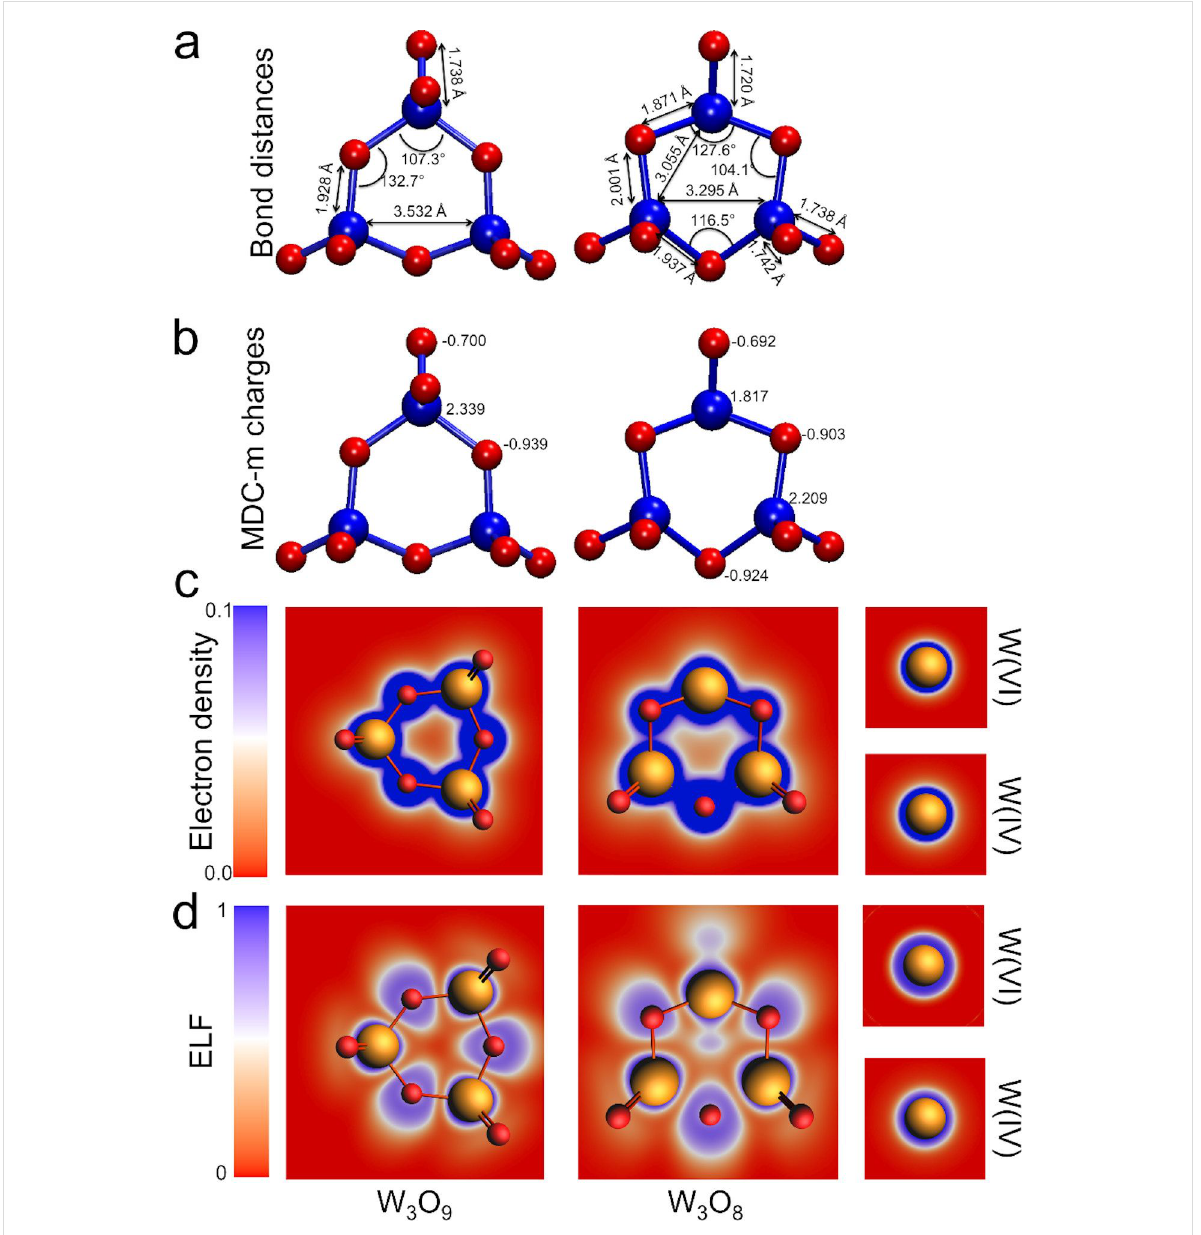
Figure 4: Structural and electronic properties of simulated W 3 O 9 and W 3 O 8 clusters. (a) Relaxed structures with the respective D 3 h and C s symme- tries and the selected bond distances and bond angles. (b) Multipole-derived charges using monopoles (MDC-m) of all atoms, showing that two types of W atoms are present in the W 3 O 8 cluster, corresponding to +VI and +IV oxidation states. (c) Total electron density ( ρ ) and (d) electron localization function (ELF). The latter two show differences in the electron density and localization not only for W atoms but also for O atoms within the hexagonal